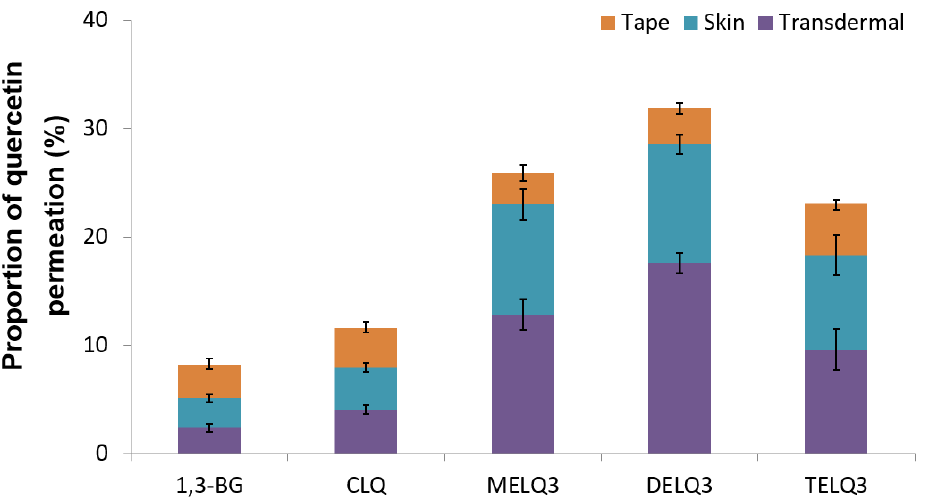
Figure 6. Proportions of permeated amount (%) of quercetin in 1,3-butylene glycol solution (1,3-BG), conventional nanoliposome (CLQ) and elastic nanoliposomes (MELQ3, DELQ3, and TELQ3) after 12 h. (Tape: stratum corneum, Skin: epidermis without stratum corneum and dermis, Transdermal: permeated through